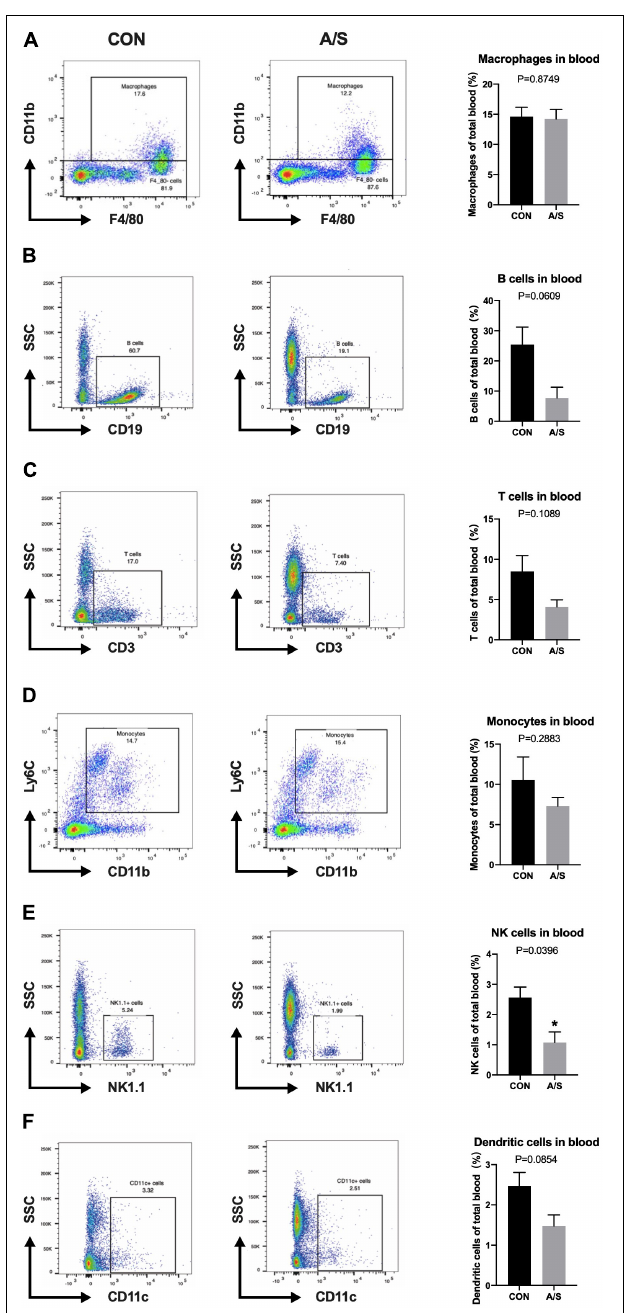
FIGURE 3 | The proportions of leukocytes other than neutrophils were not increased after anesthesia/surgery. Representative flow cytometry data of blood showed the percentage of macrophages (CD45 + CD11b + F4/80 + ), B cells (CD45 + CD19 + ), T cells (CD45 + CD3 + ), monocytes (CD45 + CD11b + F4/80 − Ly6G − Ly6C + ), NK cells (CD45 + NK1.1 + ) and dendritic cells (CD45 + CD11c + ) at 24 h after anesthesia/surgery. The percentage of NK cells ( E , P = 0.0396) were relatively decreased because of the increase of neutrophils after anesthesia/surgery compared with control group, while no significant difference was found in the percentage of macrophages ( A , P = 0.8749), B cells ( B , P = 0.0609), T cells ( C , P = 0.1089), monocytes ( D , P = 0.2883), and dendritic cells ( F , P = 0.0854). ( n = 3–4 per group). Data are expressed as means ± SE. * P < 0.05 compared with that of the control